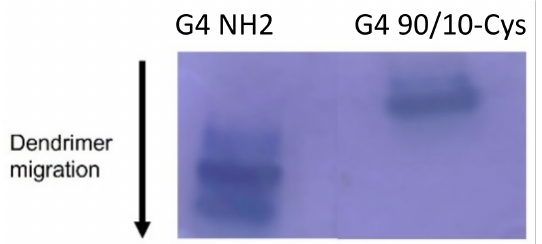
Figure 3. Migration of G4 NH 2 and G4 90/10-Cys in PAGE gel. From the migration pattern, the dendrimer with 100% amine migrated farthest (lane 1), followed by the dendrimer with 10% amines (lane 2). The migration pattern under acidic conditions reflects the concentration of amines on the dendrimer surface.